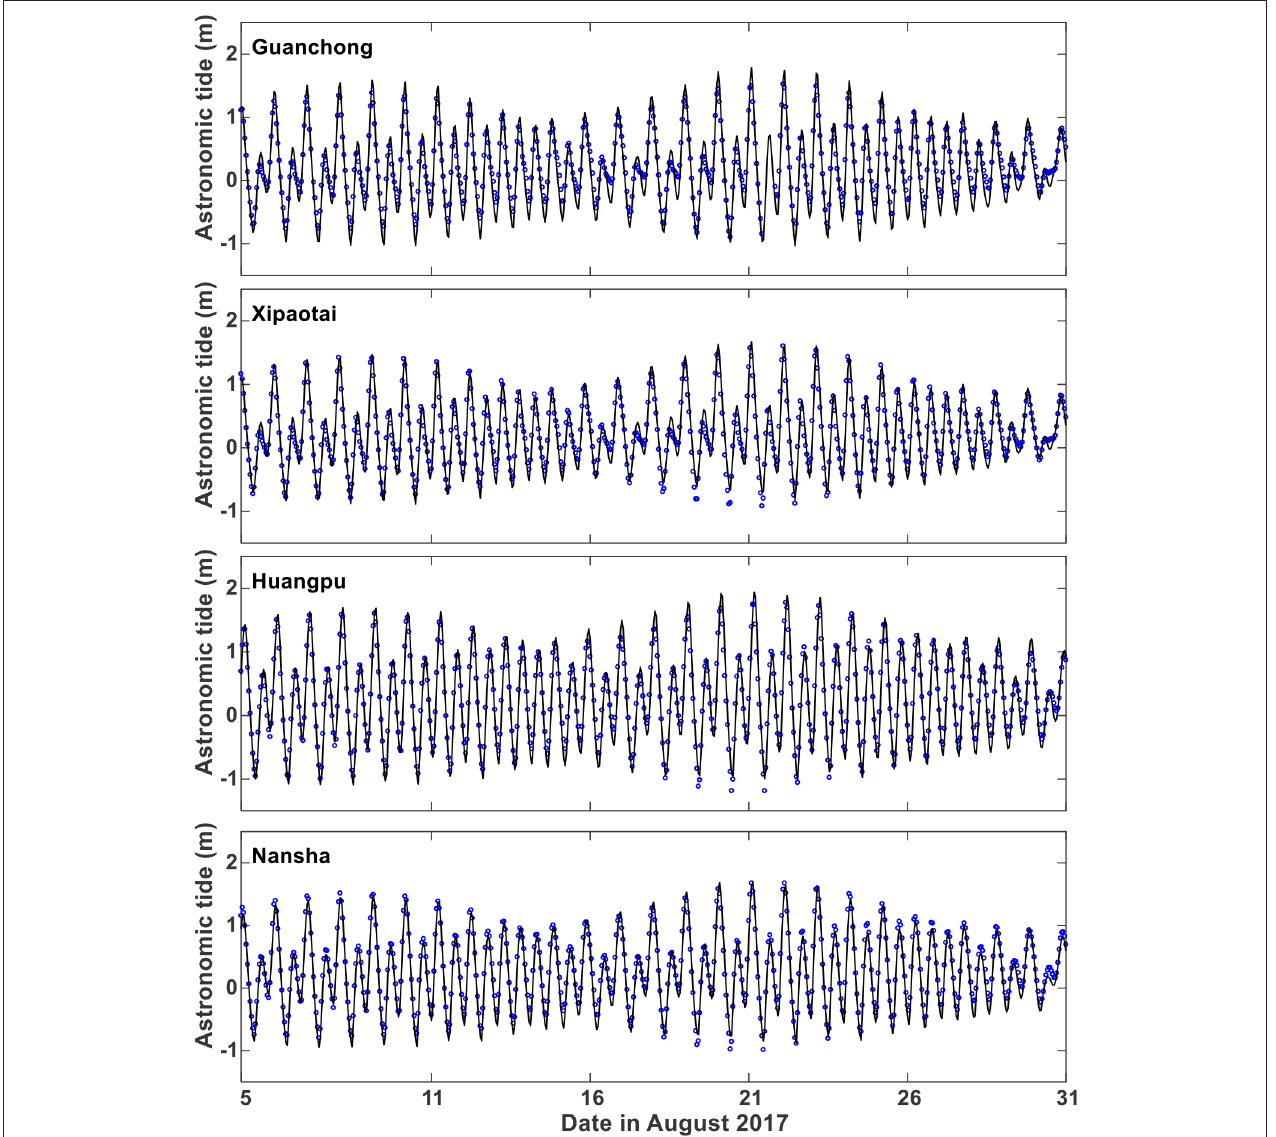
FIGURE 4 | Comparisons of model-predicted (lines) with the reconstructed (circles) astronomical tides over August 5–31, 2017, at the stations of Guanchong, Xipaotai, Huangpu, and Nansha. The reconstructed astronomical tides are calculated from the tidal constituents that were obtained from long-term harmonic analysis of the observed total water